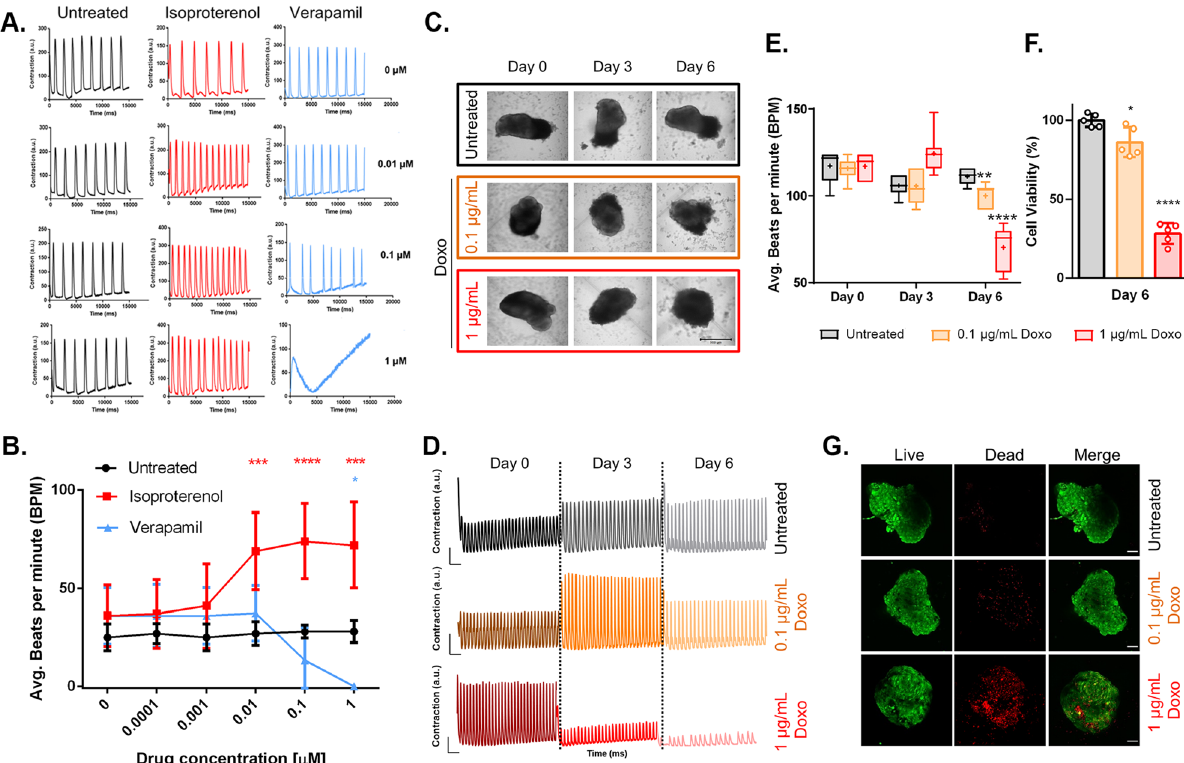
Figure 8. Long-term 3D hOCMTs show functional response to cardioactive and cardiotoxic drugs in a dose and time dependent manner. ( A ) Representative contraction amplitude plots of long-term (> day 50) Long- term 3D hOCMTs in response to untreated vs increasing doses of Isoproterenol and Verapamil. ( B ) Average beating rates of 3D long-term cardiac microtissues hOCMTs in response to increasing doses of Isoproterenol and Verapamil (n = 3, Mean ± SD, Dunnett’s multiple comparisons test). ( C ) Morphology of 3D long-term (> day 50) Long-term 3D hOCMTs in response to untreated vs increasing doses of Doxorubicin (Doxo) over 6 days (scale bar = 500 µm). ( D ) Representative contraction amplitude plots of Long-term 3D hOCMTs in response to untreated vs increasing doses of Doxo over 6 days (t = 15 s). ( E ) Average beating rates of Long-term 3D hOCMTs in response untreated vs increasing doses of Doxo over 6 days (n = 6, Lines = Median ± min/max, Dots = Mean value, Dunnett’s multiple comparisons test). ( F ) Luminescence-based quantification of cell viability Long-term 3D hOCMTs on day 6 of Doxo treatment normalized to untreated samples (untreated vs 0.1 µg/mL vs 1 µg/mL) (n = 6, Mean ± SD, Tukey’s multiple comparisons test). ( G ) Representative cell viability of v on day 6 of Doxo treatment (untreated vs 0.1 µg/mL vs 1 µg/mL) with Calcein/AM staining, green = live, red = dead (Scale bar = 100